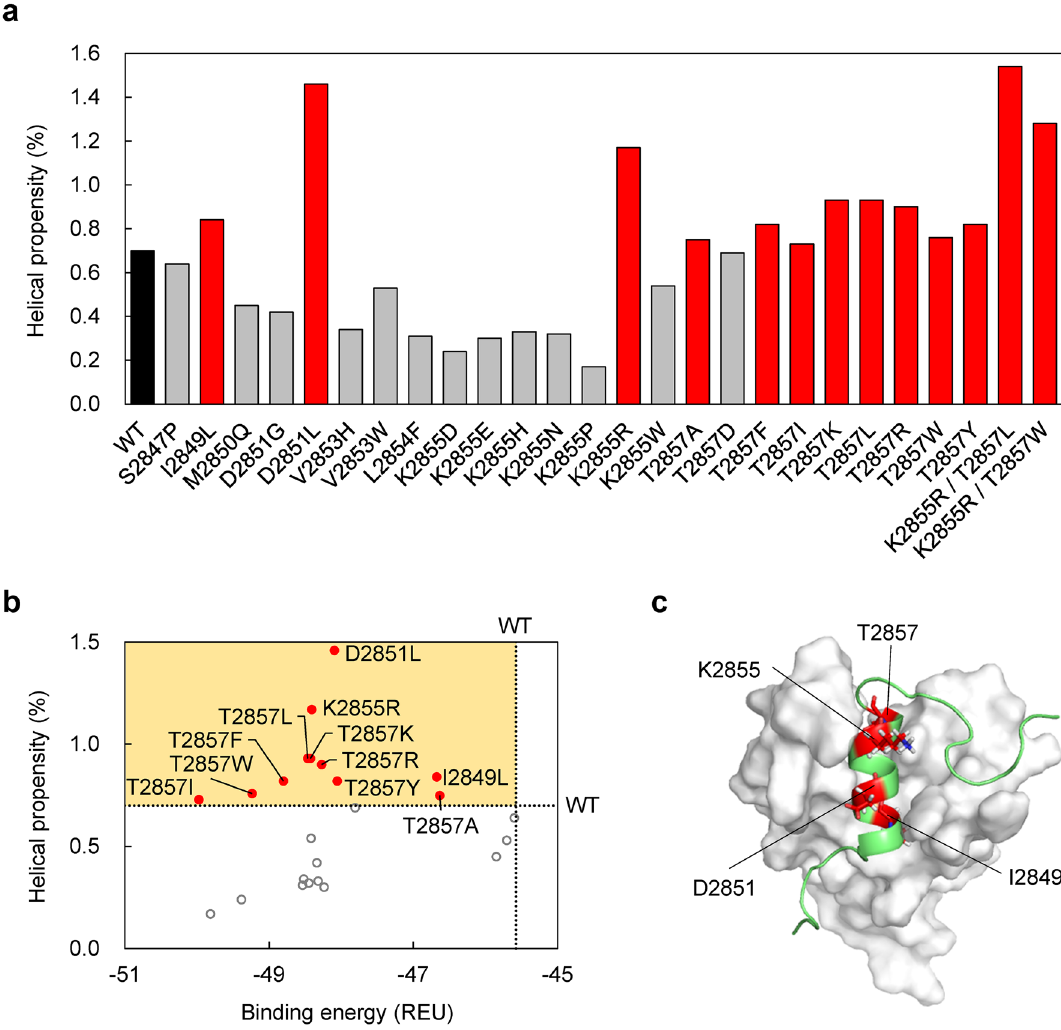
Figure 3. Selection of MLL TAD mutants. ( a ) The helical propensity of the wild type (WT, black) and mutants of MLL TAD predicted using AGADIR. The average of the residue-specific helical propensities (Supplementary Fig. 3) is shown. The mutants with higher or lower helical propensities than that of the WT are shown in red and grey, respectively. ( b ) The helical propensity plotted against the binding energy (average dG_separated value in Rosetta energy unit [REU]). The dotted lines show the values for the WT. Eleven single mutants (red filled circles) with a helical propensity higher than the wild type (in the yellow region) were selected for experimental characterization. ( c ) Four mutation sites for the 11 selected mutants are shown in red on the KIX:MLL complex structure (PDB ID: 2AGH). The figures were created with Microsoft Excel for Microsoft 365 (Microsoft Corp., Redmond, WA, USA; https:// www. office. com) and with PyMOL Molecular Graphics System, Version 2.4.0 Schrödinger, LLC (https:// pymol.